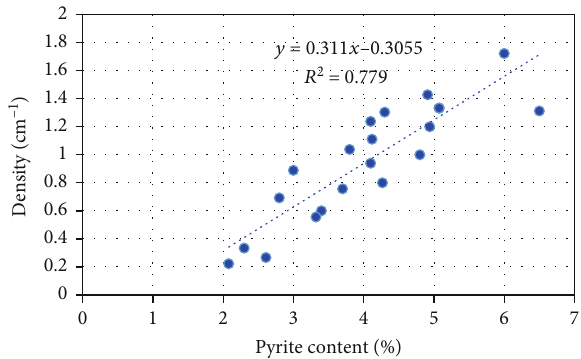
Figure 7: Relationship between density of lamellation fractures and pyrite content in the Qianjiang Depression.